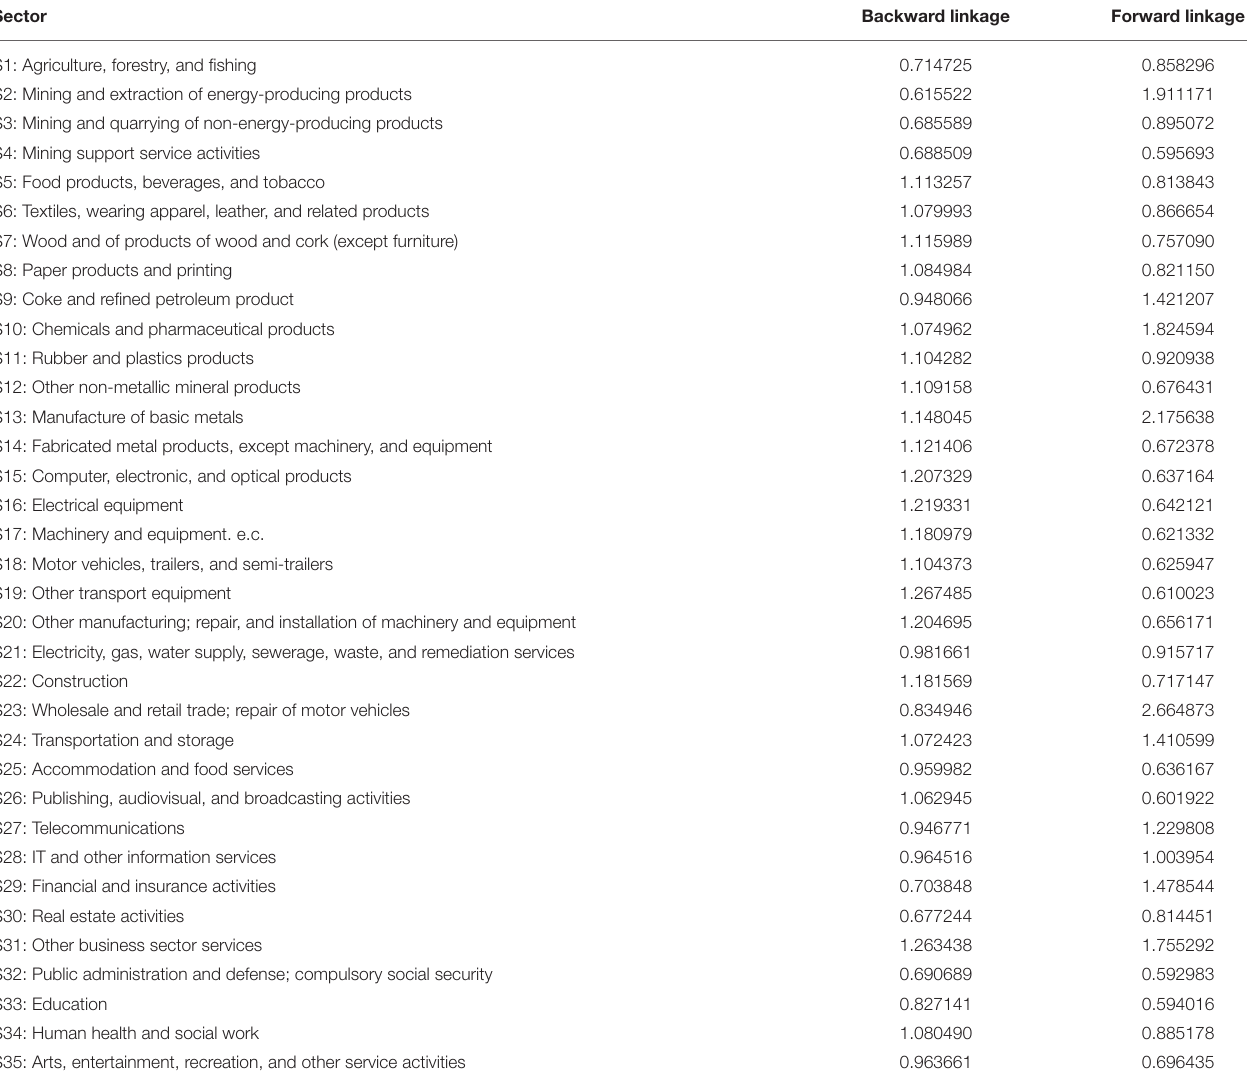
TABLE 1 | Hirschman/Rasmussen backward and forward linkages for the Arabia Saudi sector 2018. Sector Backward linkage Forward